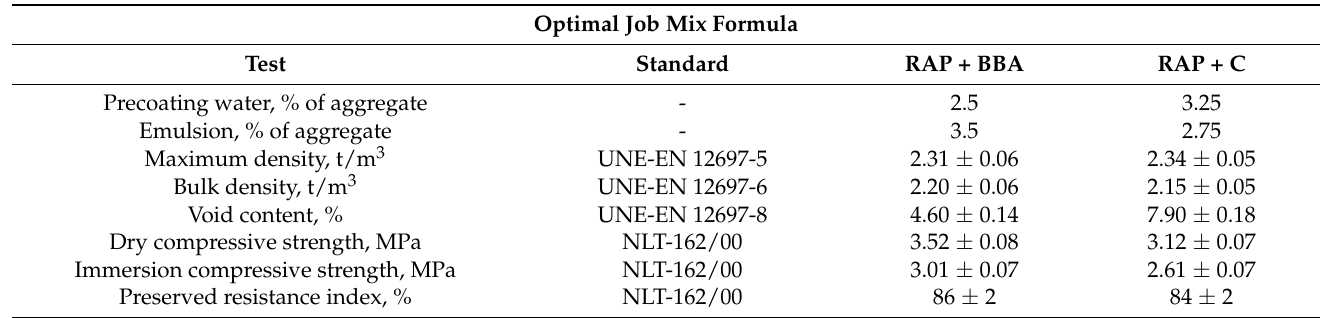
Table 9. Families of test samples formed with RAP and BBA or limestone